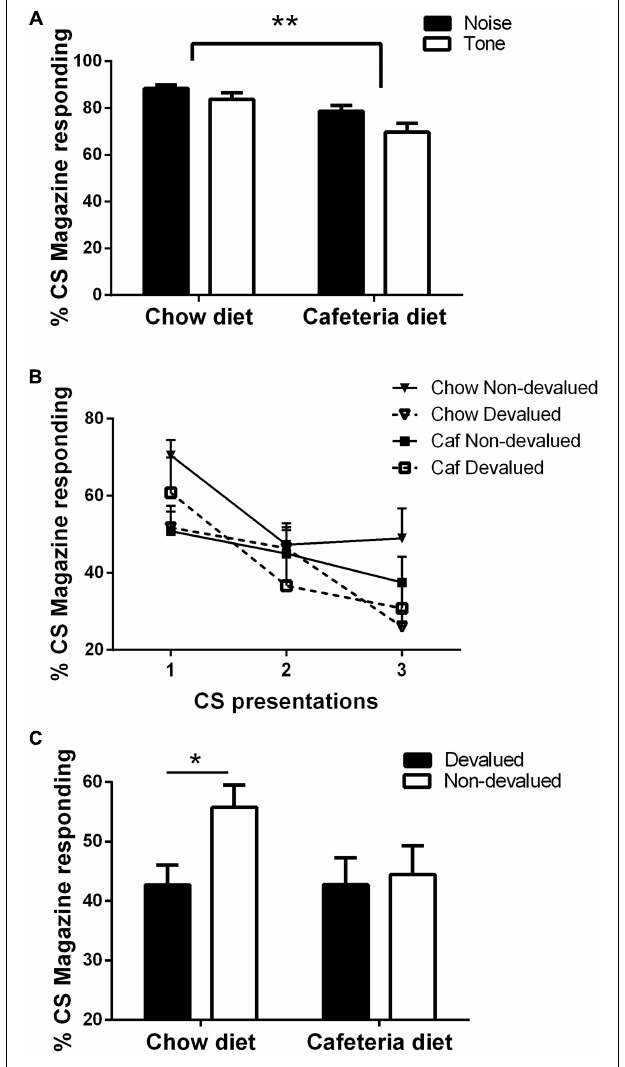
FIGURE 3 | (A) Magazine responding in the final training session; (B) Magazine responding (Mean CS1-3) at test and (C) Mean magazine responding at test across all CSfor chow diet rats ( N = 14) and cafeteria diet rats ( N = 15). Data presented as mean ( ± SEM). * p < 0.05, ** p < 0.01 Bonferroni